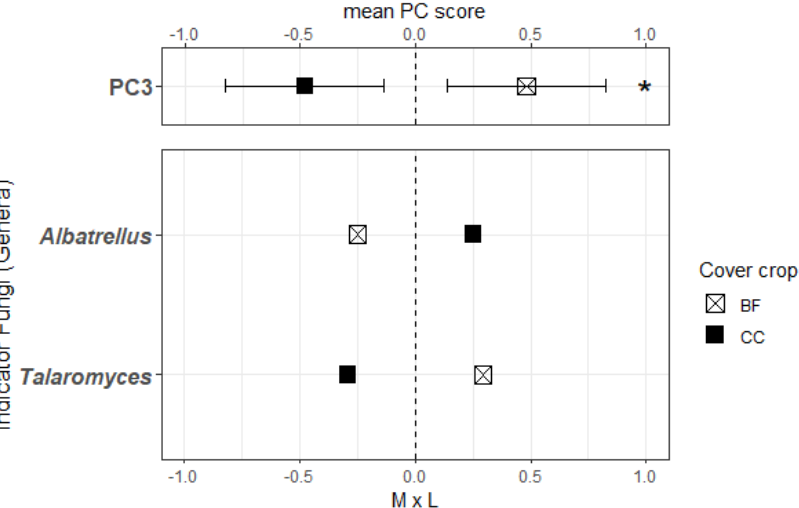
Figure 7. The top panel shows the estimated mean principal component (PC) scores of the fungal PC3 for each level of cover cropping treatment with their standard errors of the mean as whiskers. The asterisks indicate the probability value of the treatment effect from analysis of variance (*: p < 0.1). The bottom panel shows the contribution of each fungal indicator to PC3 multiplied by the mean PC scores of each level of cover cropping treatment (M × L). The treatment levels are bare fallow (BF; crossed box) and cover crop mixture (CC; filled box).